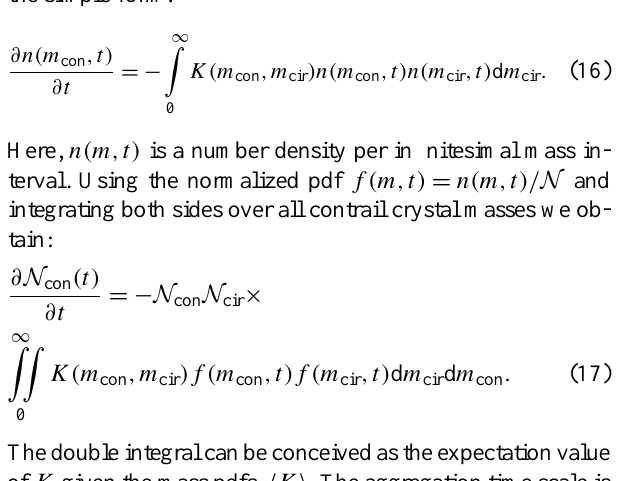
Fig. 1. Isolines of τ cond /τ jet , the ratio of the condensation time scale to the jet expansion time scale vs. plume age during contrail formation (first second) and vs. number concentration of ice crys- tals in the ambient cirrus for various conditions: (a) T = − 40 ◦ C, p = 300 hPa, (b) T = − 50 ◦ C, p = 250 hPa, (c) T = − 60 ◦ C, p = 200 hPa. Note that crystal number concentrations for cirrus clouds exceeding 10 cm − 3 are unrealistic. On the contrary, number con- centrations in young contrails are of the order 10 4 to 10 5 cm − 3 .